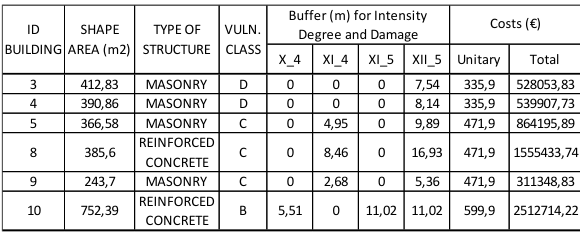
Table 7. Clutter of debris and adjustment costs for six